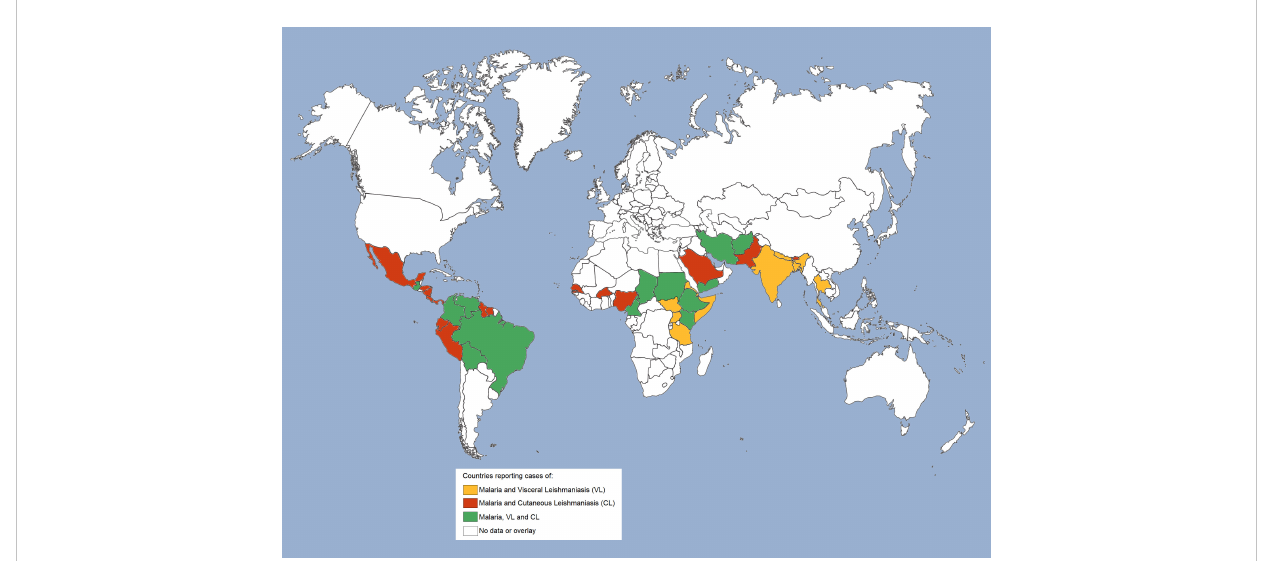
FIGURE 2 Geographical overlap of malaria and leishmaniasis cases worldwide. Geographical distribution of countries co-endemic for malaria and leishmaniasis. Cases of malaria and visceral leishmaniasis (VL) are reported in countries highlighted in mustard; cases of malaria and cutaneous leishmaniasis (CL) are reported in countries highlighted in red, and cases of malaria and both leishmaniasis (VL and CL) are reported in countries highlighted in